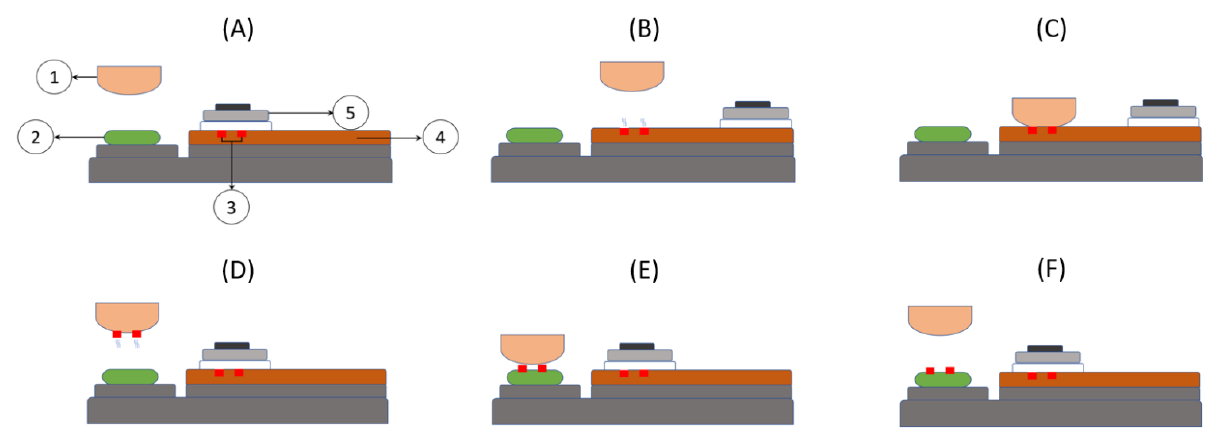
Figure 1. Schematic view illustrating the pad-printing process. The pad-printing cycle takes place in several steps: ( A ) Rest position with (1) Pad, (2) Substrate, (3) Inked engraved pattern, (4) Cliché and (5) Ink cup. ( B ) The ink cup moves to allow the thinner from the top surface of the inked engraved pattern to evaporate. At the same time, the pad moves laterally to the position above the ink to be transferred. ( C ) The pad moves down to pick up the patterned ink film. ( D ) The pad moves up first and then moves laterally above the substrate. During this time, the thinner from the lower surface of the ink film evaporates. ( E ) The pad moves down in contact with the substrate to deposit the ink film while the ink cup returns over the cliché pattern to fill it with ink. ( F ) The pad goes up and the ink layer is deposited on the substrate.